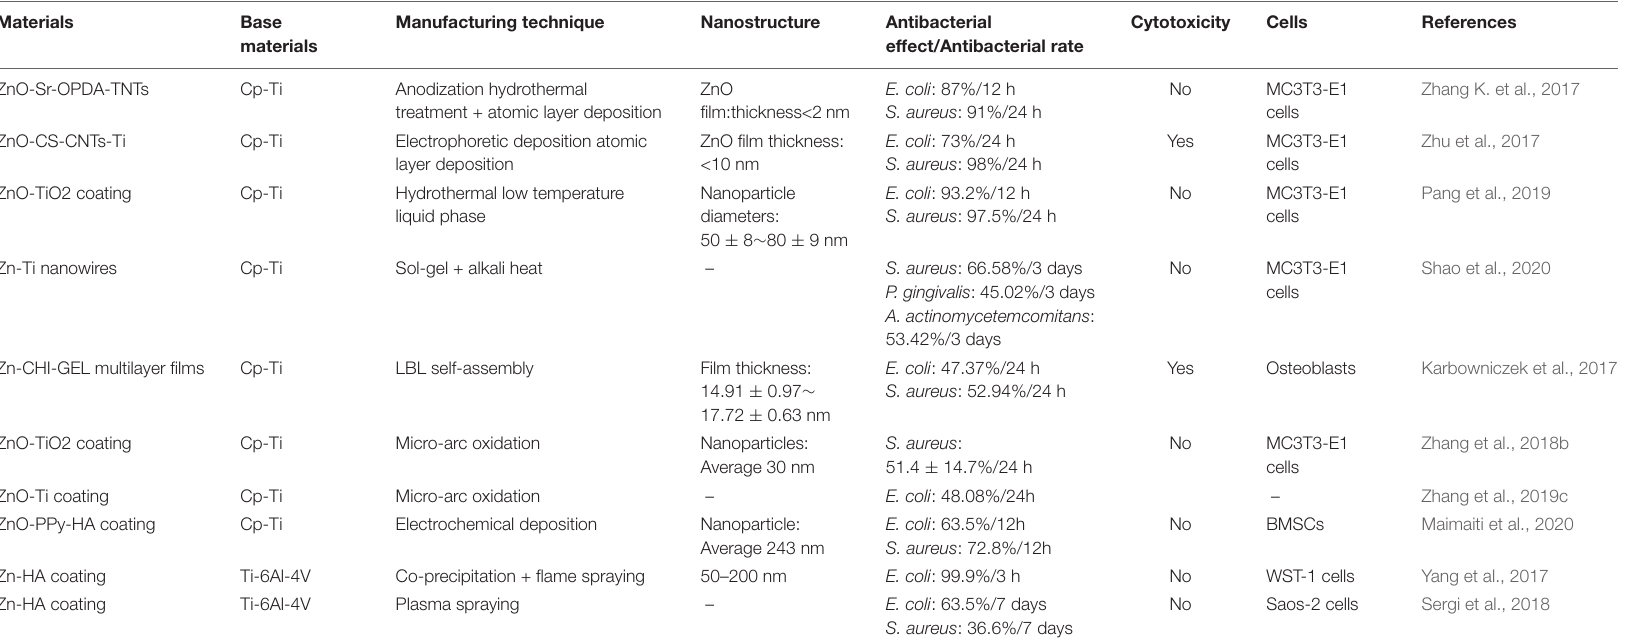
TABLE 5 | Different antibacterial properties and biocompatibility of zinc-containing coatings.